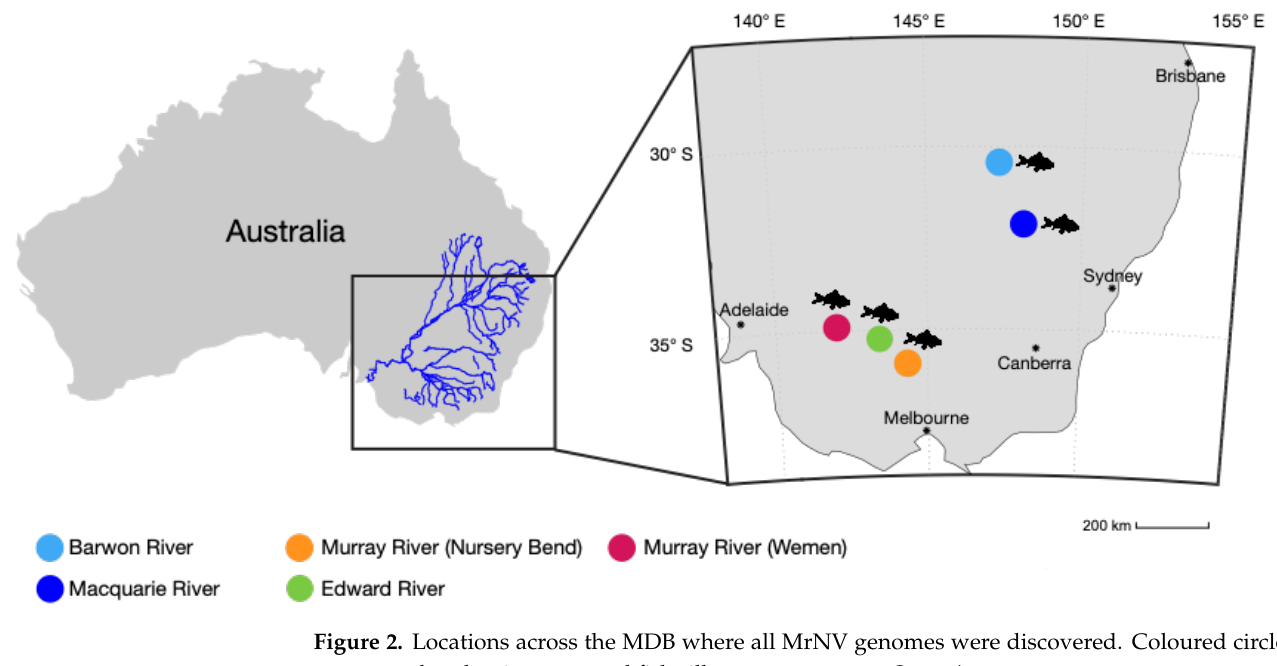
Figure 2. Locations across the MDB where all MrNV genomes were discovered. Coloured circles correspond to the site name and fish silhouettes represent C. carpio .